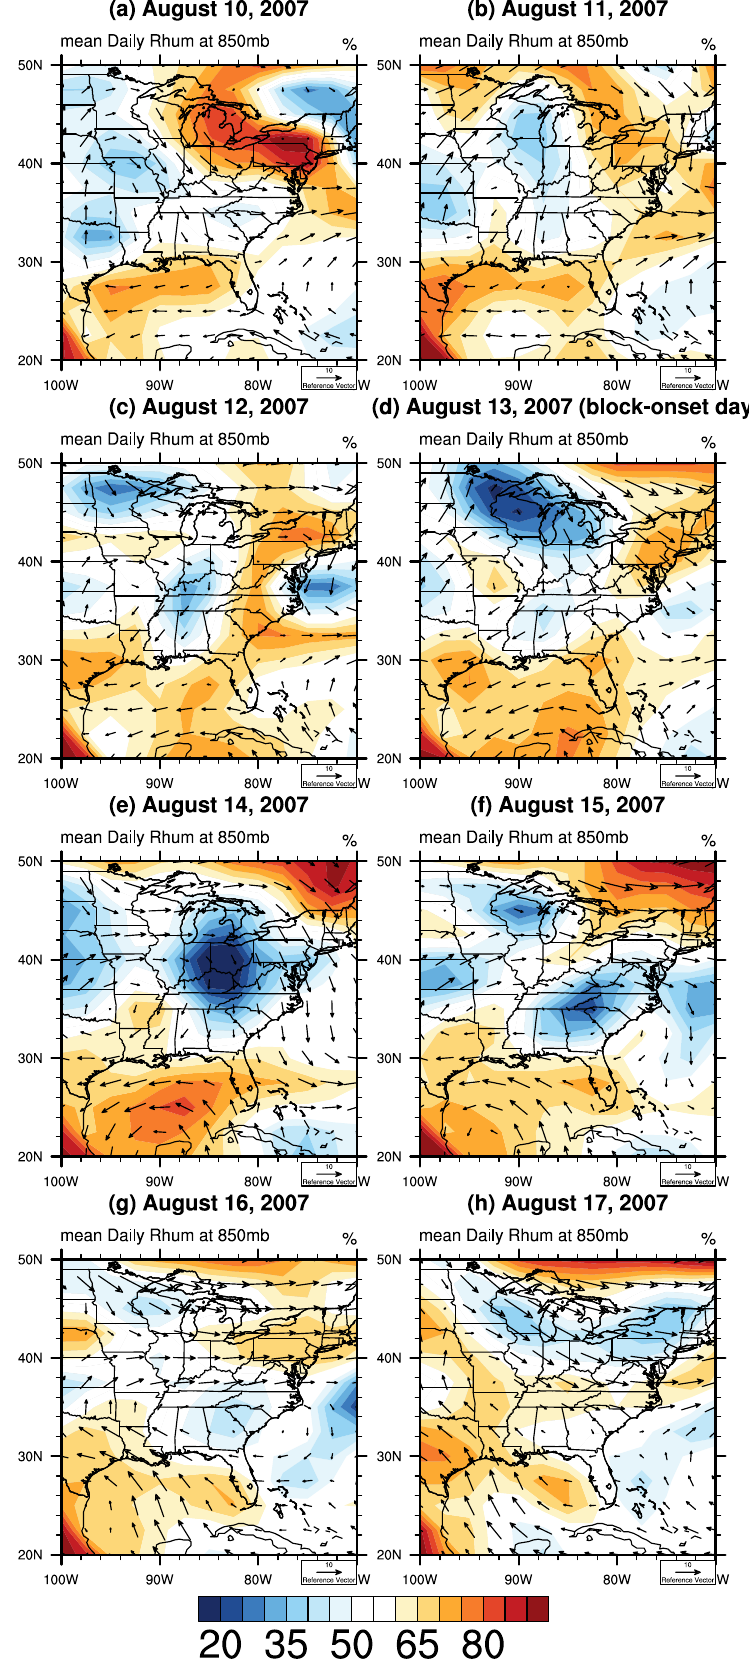
Figure 8. 850-mb relative humidity (%) from 10 August 2007 ( a ) to 17 August 2007 ( h ), overlaid with 850-mb wind vector (ms − 1 ), during the evolution of August 2007 blocking